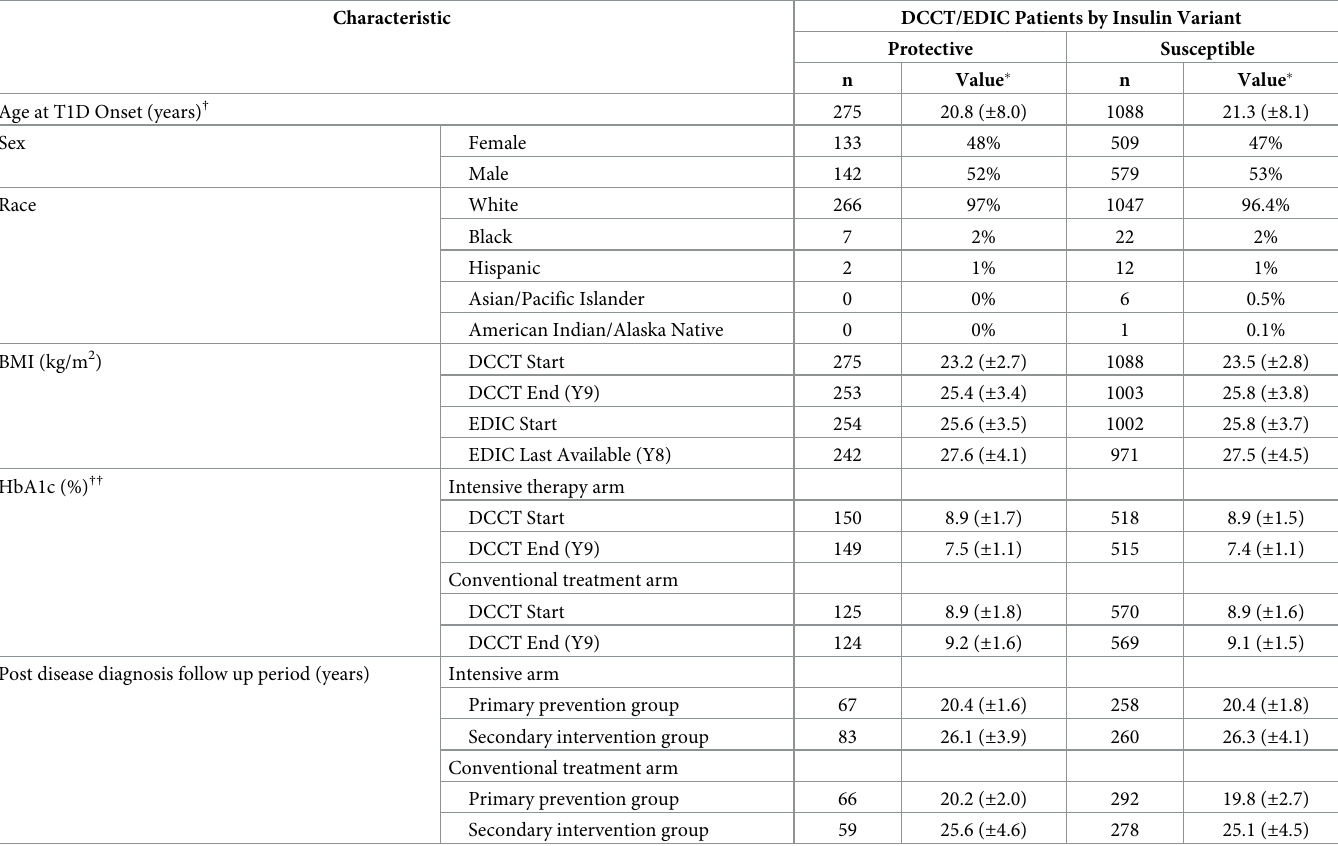
Table 1. DCCT/EDIC patient characteristics by insulin gene